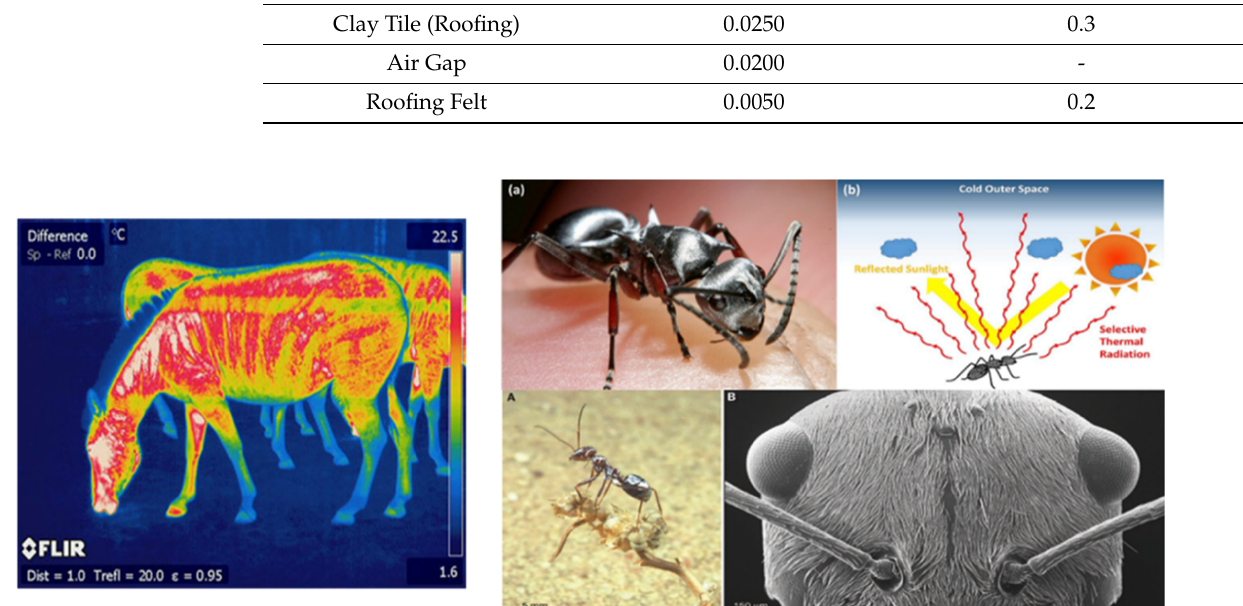
Figure 4. Convection currents due to temperature variation in the black and white lines. Infrared photo with the respective surface temperature variations ( left ). Characteristics of the Saharan ant ( right ) ([17,41]).